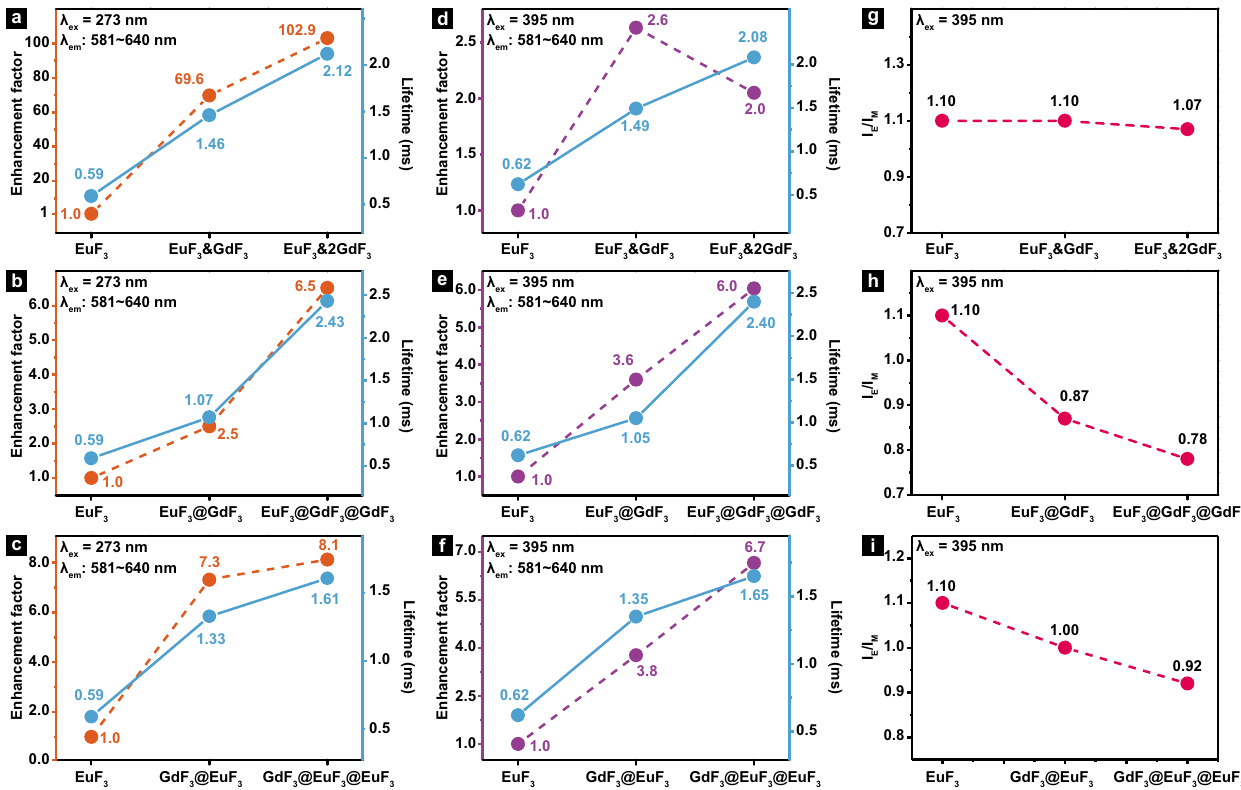
Fig. 5 The PL evolution in different-structured NCs. a – c Variation of luminescence enhancement factor (orange lines) and lifetime (baby blue lines) of Eu 3 + in different NCs under 273 nm light excitation, through Gd 3 + – Eu 3 + energy transfer. d – f Luminescence enhancement factor (purple lines) and lifetime (baby blue lines) of Eu 3 + in different NCs under 395 nm light excitation. g – i Normalized I E /I M value of Eu 3 + in different NCs.